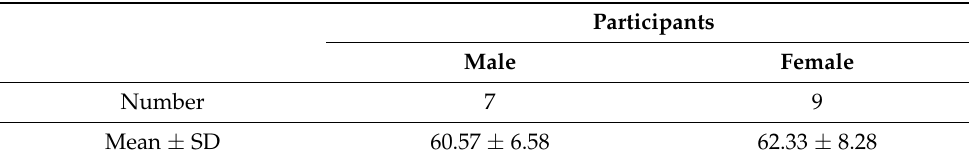
Table 1. Basic participant information statistics